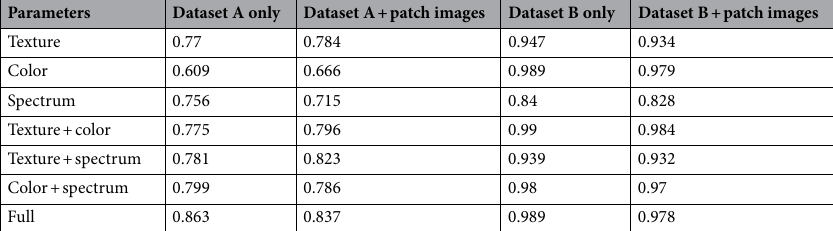
Table 5. Classification results of the RF model according to dataset types. It shows the F1-score of the performance of the RF model. We trained the classifier using combinations of features extracted from the new dataset (including patch images) or the initial dataset and identified the difference of classification performance of the RF model.